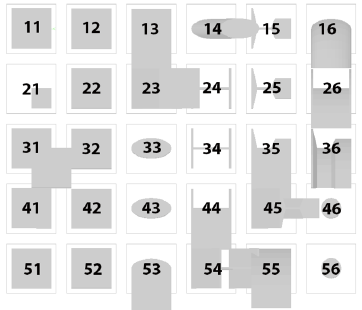
Figure 11. Reference grid for geometries description.